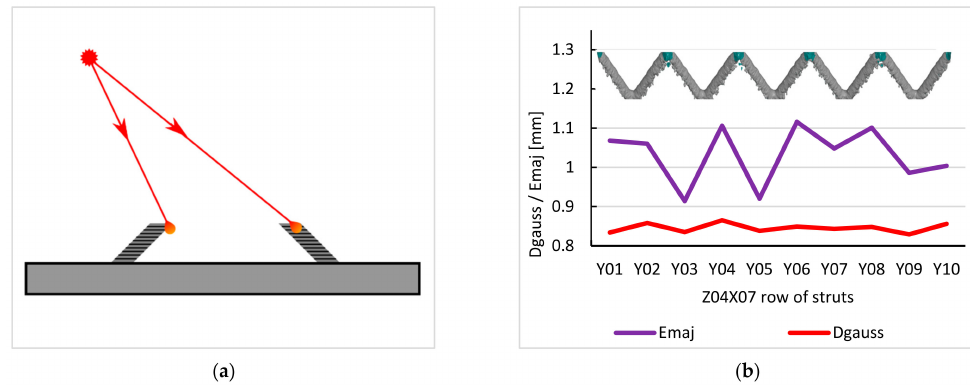
Figure 13. ( a ) Different direction of the laser source to each strut of the BCC unit cell and the resulting higher down-skin surface roughness on some of the struts. ( b ) Changes of the D GAUSS and E MAJ parameters over one row of struts in #2–d0.7 mm, showing a systematic variation of the surface roughness on the down-skin surfaces and proving the effect of the laser source to strut